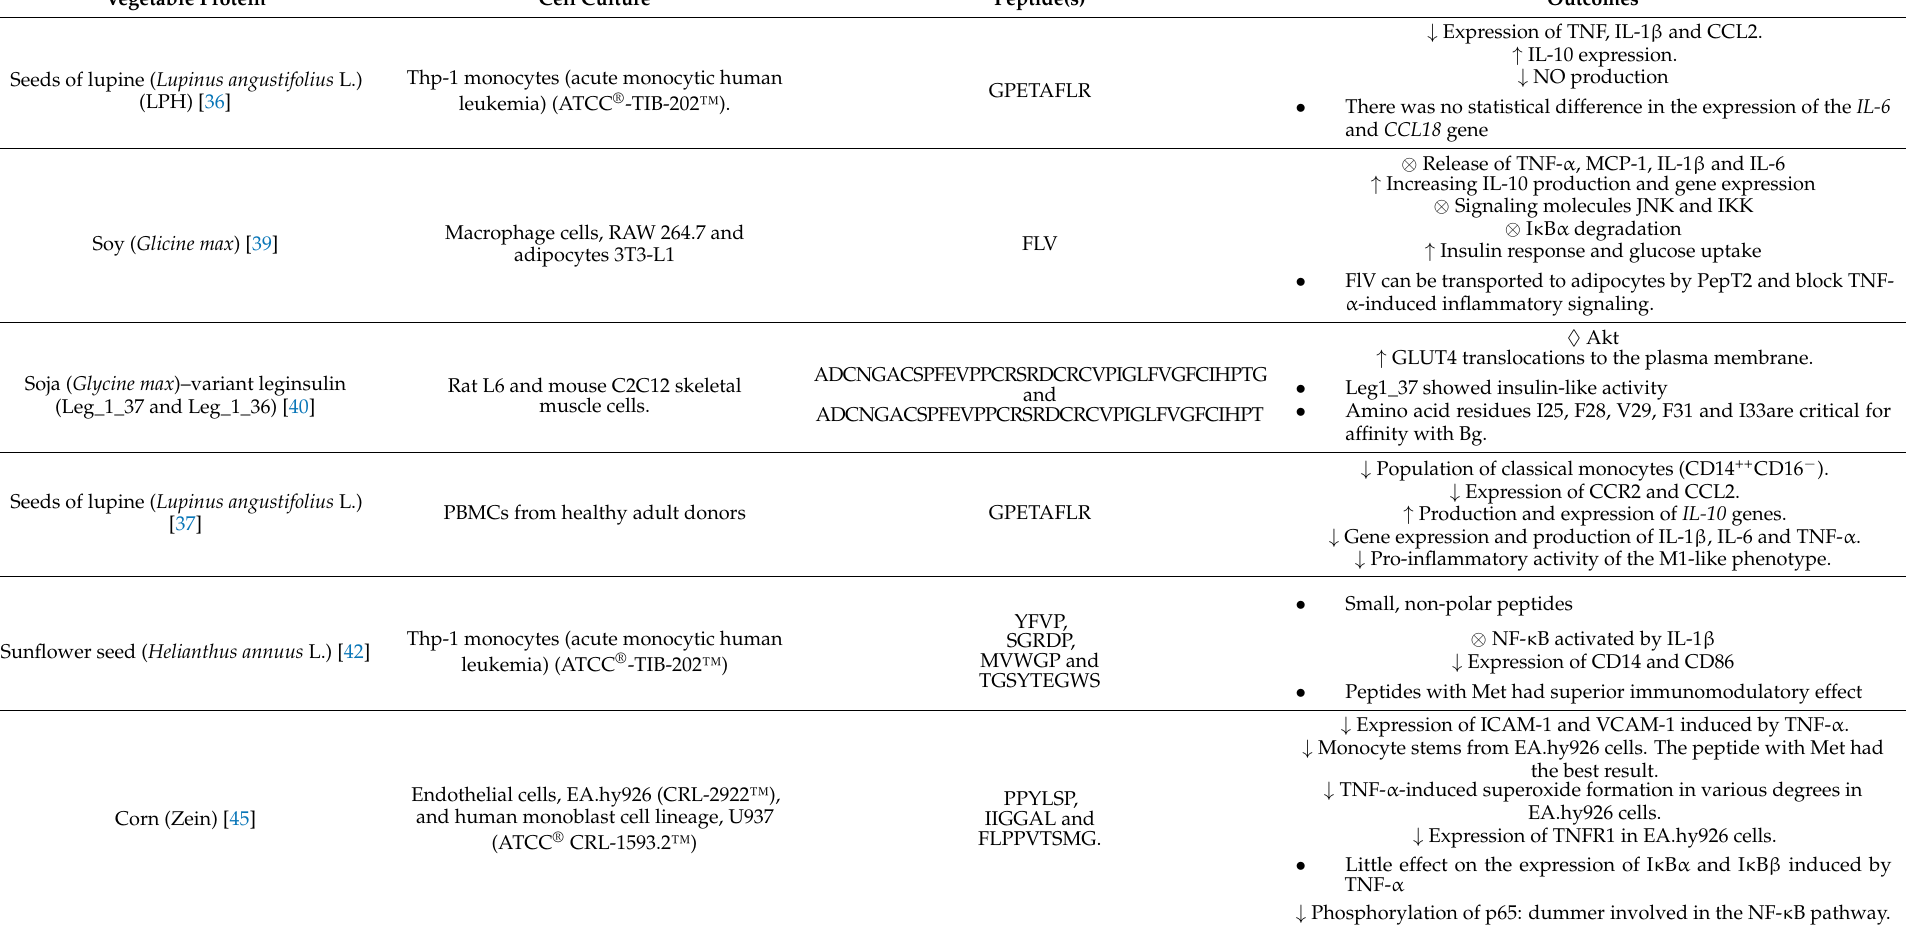
Table 2. Anti-inflammatory and immunomodulatory effects of plant peptides reported in the